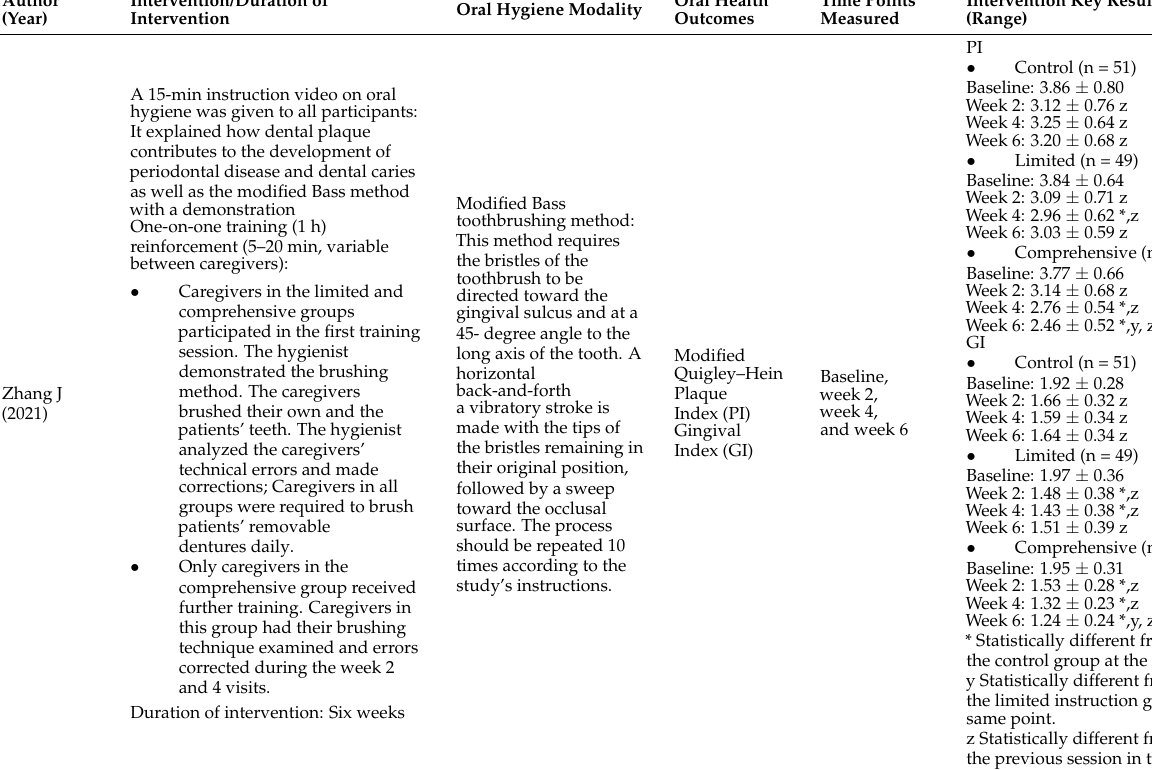
the control group at the same point. y Statistically different from the mean of the limited instruction group at the same